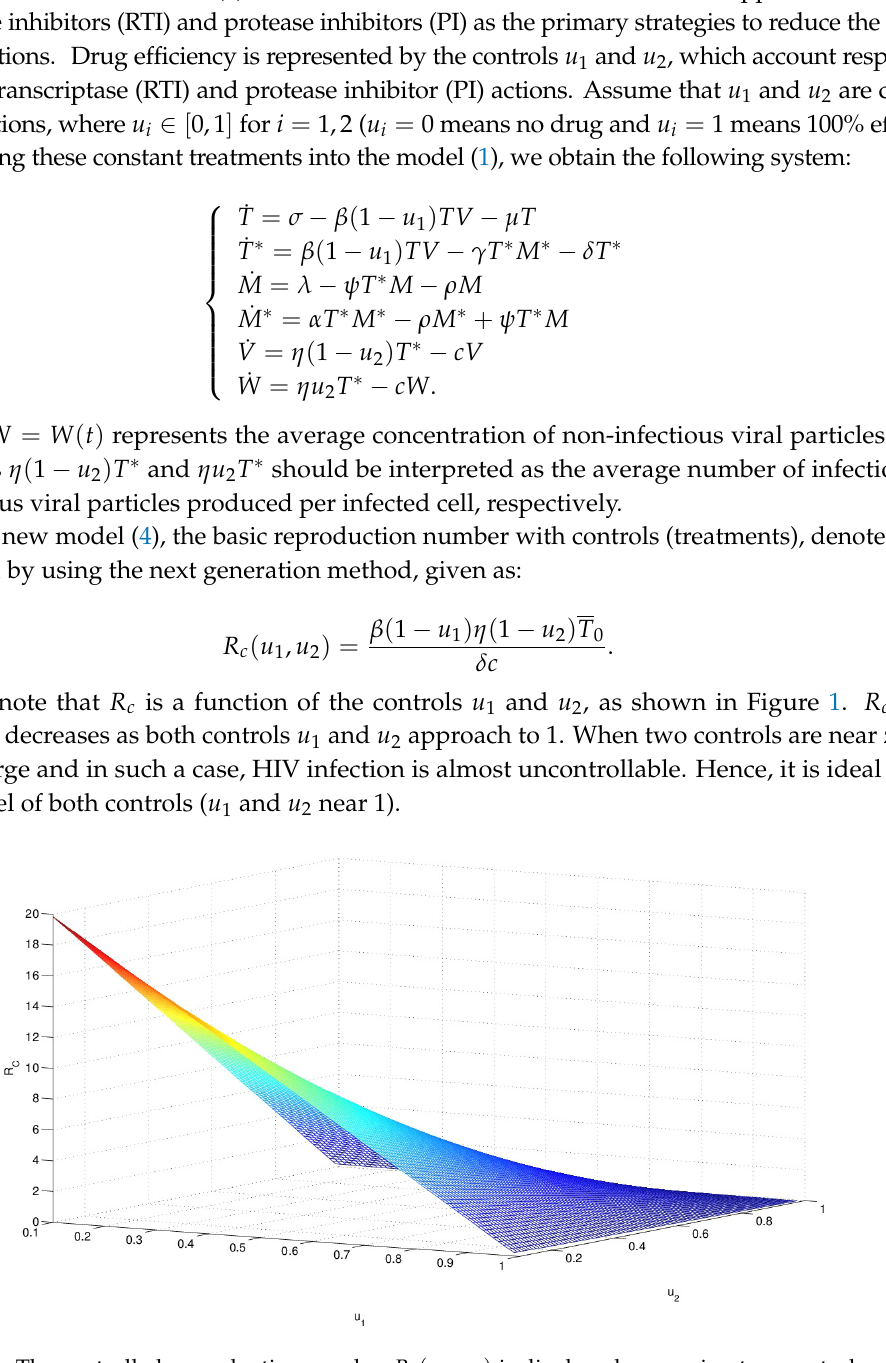
Figure 1. The controlled reproduction number R c ( u 1 , u 2 ) is displayed as varying two controls with u 1 ∈ [ 0,1 ] and u 2 ∈ [ 0,1 ] . R c ( u 1 , u 2 ) monotonely decreases as both controls u 1 and u 2 approach